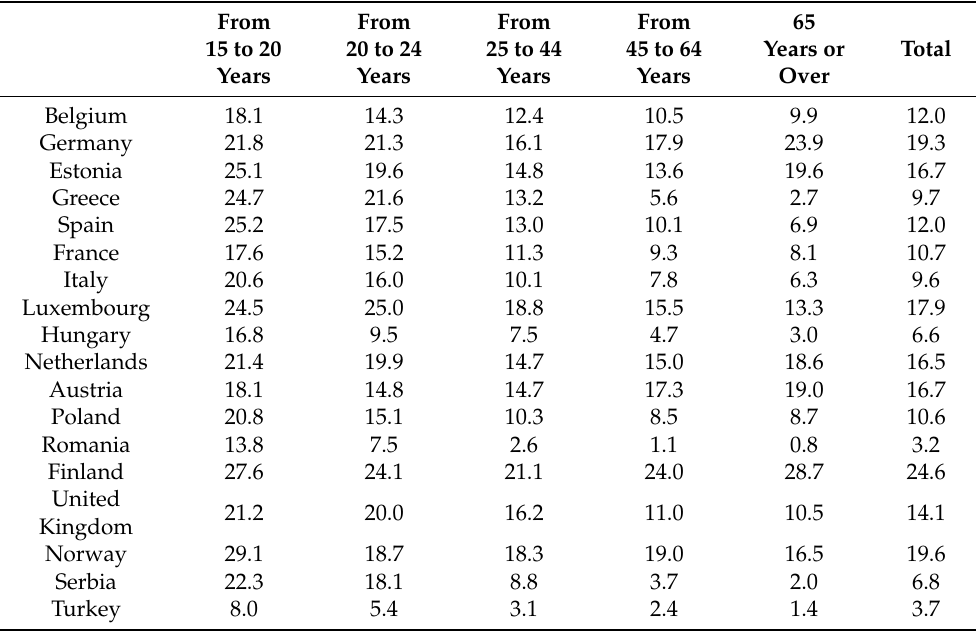
Table 2. Participation rate in sports and outdoor activities (except walking and hiking) by age group (%).